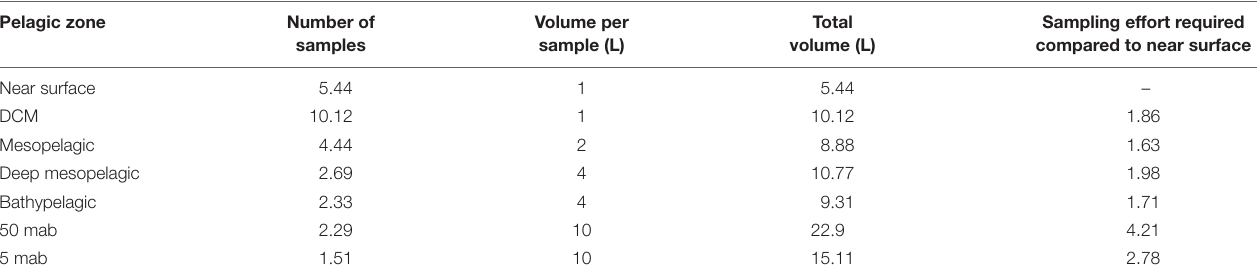
Pelagic zone Number of